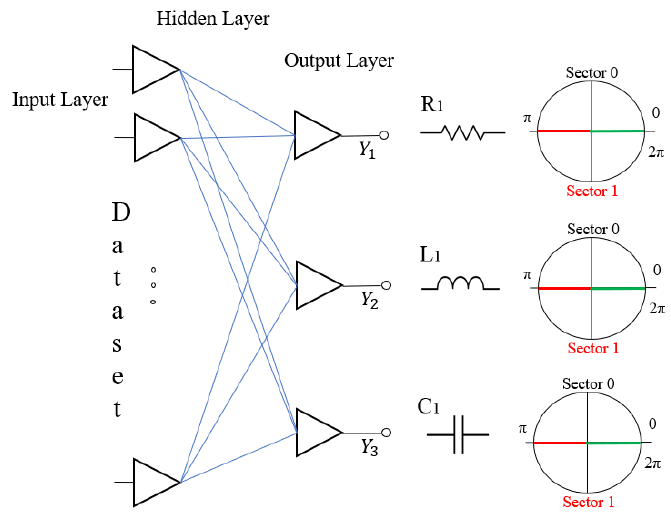
Figure 2. Configuration of the output layer of the MLMVN (example).